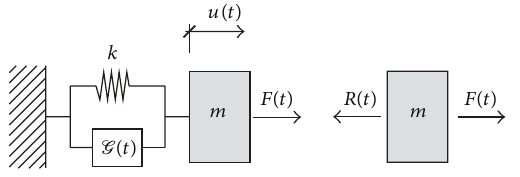
Figure 1: Schematic representation of the viscoelastic